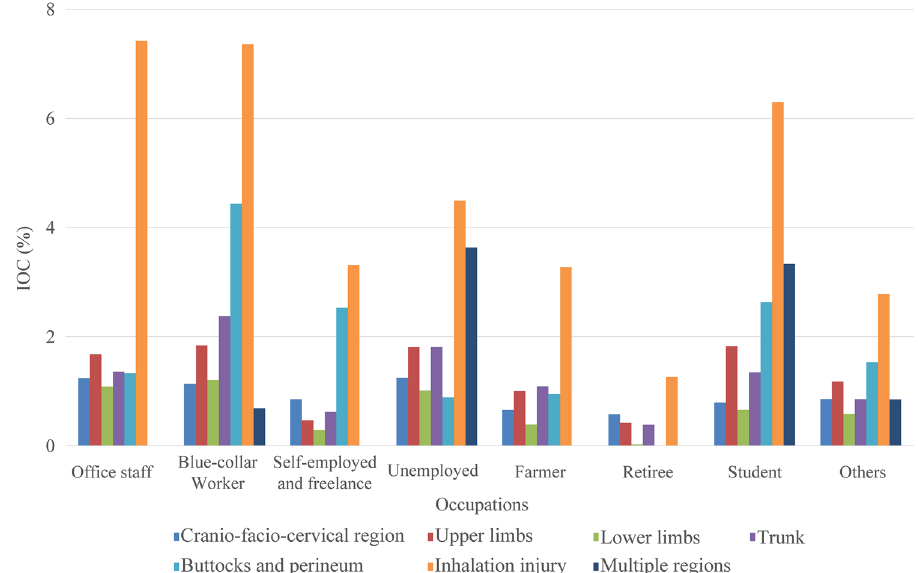
Figure 6. IOC of different anatomic site burned inpatients in different occupations. The X-axis represents the occupations. The left Y-axis corresponding to the bars represents the IOC of each burn site group in burn inpatients. Abbreviation: IOC the incidence of scar contracture associated re-hospitalisation.